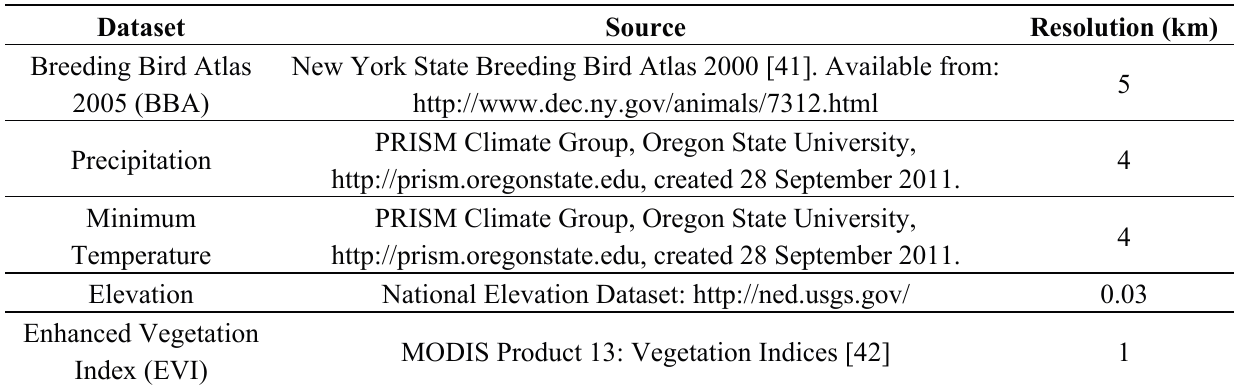
Table 1. Source and resolution of data used in